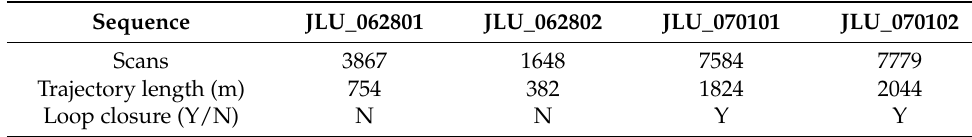
Table 2. Details of the JLU campus